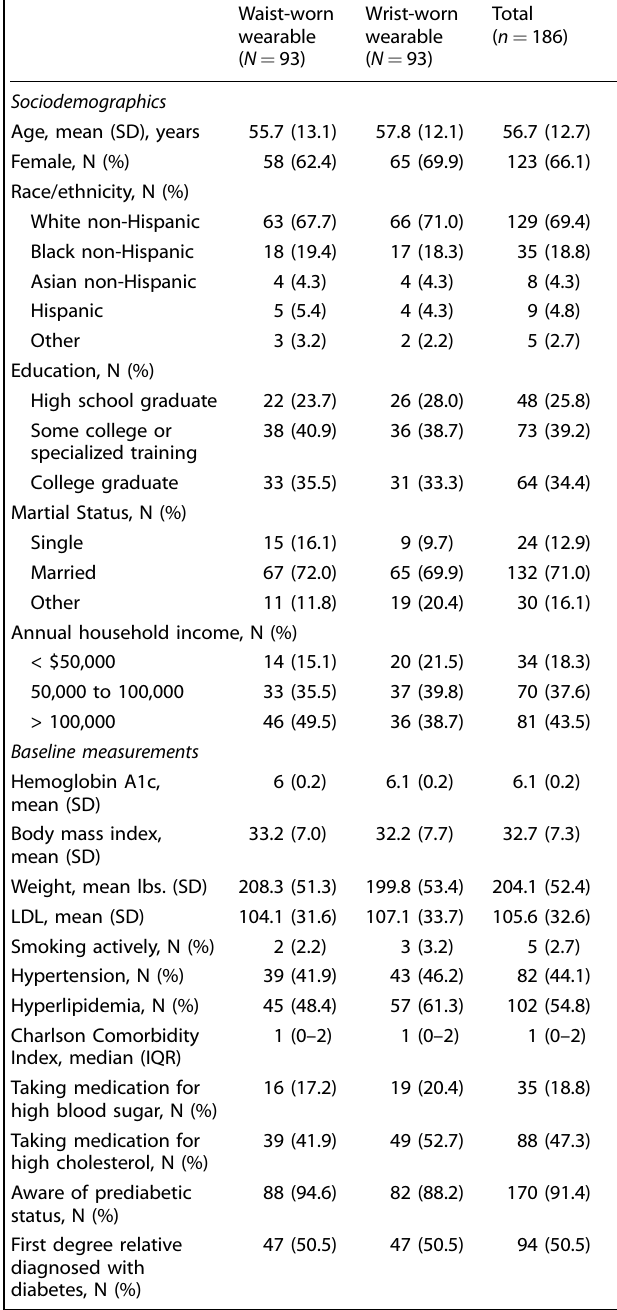
Table 1. Characteristics of the participant